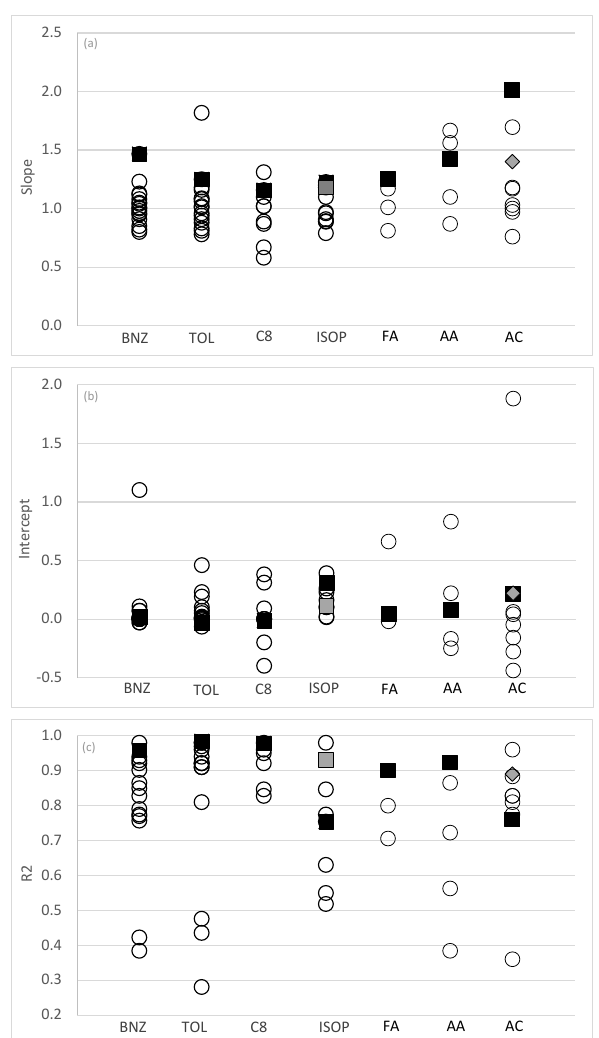
Figure 2. (a–c) Slopes, intercepts (ppbv) and correlation coefficient from linear regression ( x , y ) analyses between PTR-MS ( y ) and in- dependent VOC measurement techniques ( x ) from this study (black squares) and other published studies (open circles). BNZ – ben- zene; TOL – toluene; C8 – C 8 aromatics; ISOP – isoprene; FA – formaldehyde; AA – acetaldehyde; AC – acetone. Note that grey squares are determined from analysis of isoprene afternoon data from this study. Grey diamonds are determined from the analysis of DNPH acetone excluding periods affected by condensation (average dew point temperature < 7 ◦ C). Published studies used in this figure are referred to within the text for each compound Sects.